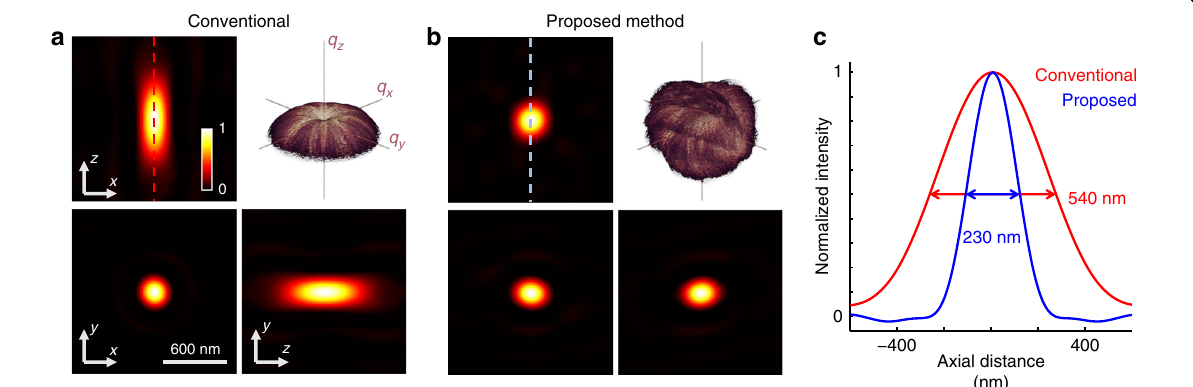
Fig. 5 Resolution analysis. a , b Sliced images of the 3D CSFs obtained from ( a ) conventional ODT and ( b ) using our proposed method. Insets, coherent transfer functions used to de fi ne CSFs c Axial line pro fi les of the CSFs along the coloured lines in ( a ) and ( b) . FWHM of the conventional ODT and our proposed method are